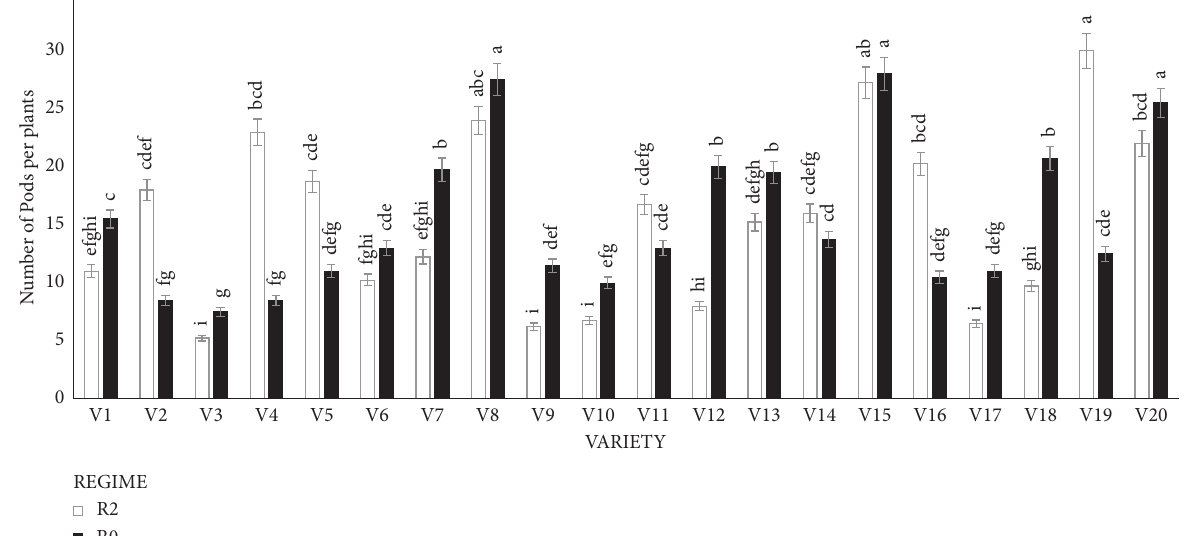
Figure 3: Effect of drought stress on the number of pods at the reproductive stage.